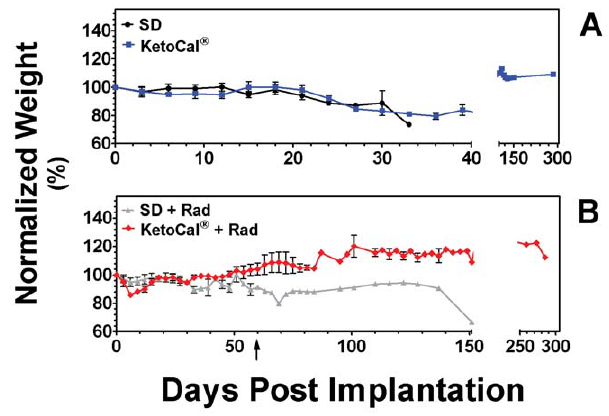
Figure 4. Animal weights. Weight measurements were taken every 3 days. Graph shows animals weights normalized to the average starting weight of each group on day zero. (B) Arrow denotes a long-term survivor 60 days following tumor implantation in the SD plus radiation group.